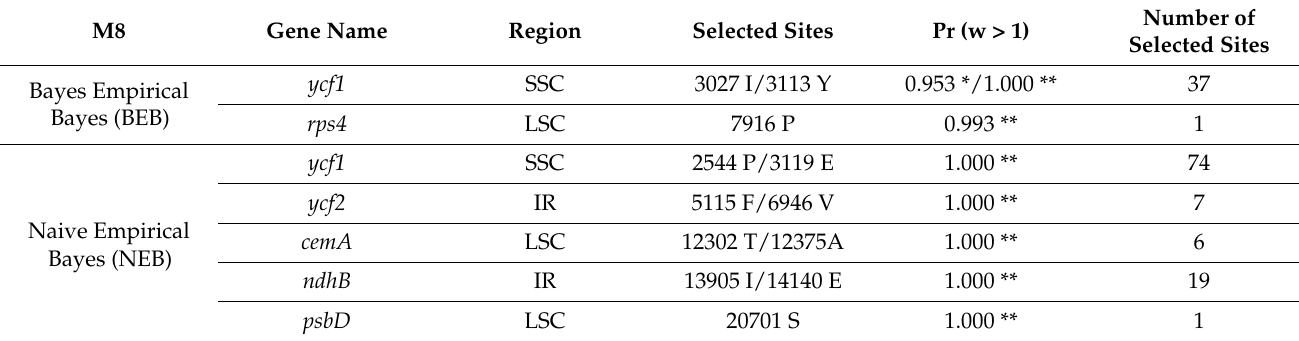
Number of Selected Sites